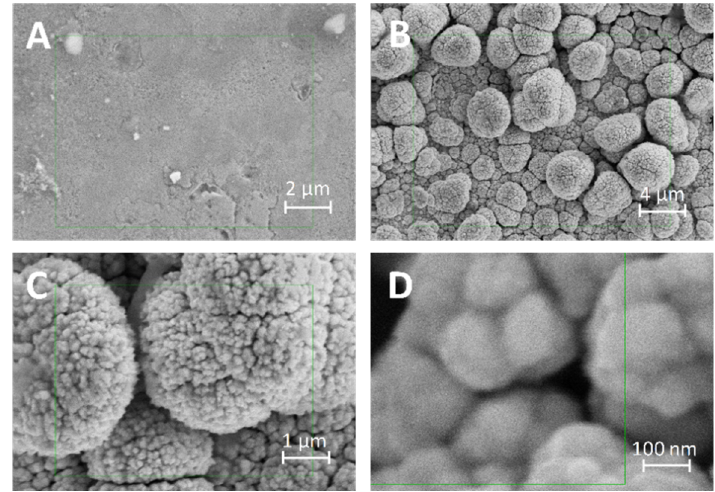
Figure 3. SEM images of the morphology of the electrode surface before ( A ) and after 300 cycles ( B – D ): gold surface prior to modification ( A ), nanoporous platinum surface at ×5k ( B ), ×20k ( C ) and ×60.1k magnification ( D ).